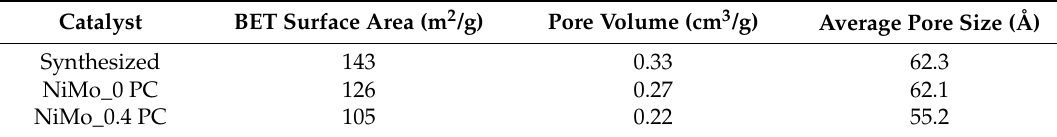
Table 2. Surface area (BET), pore volume, and pore size of the